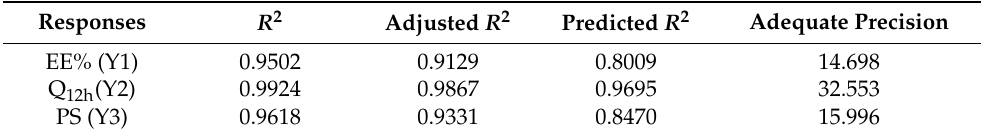
Table 2. The output data of the 2 3 factorial design of EGCG-loaded